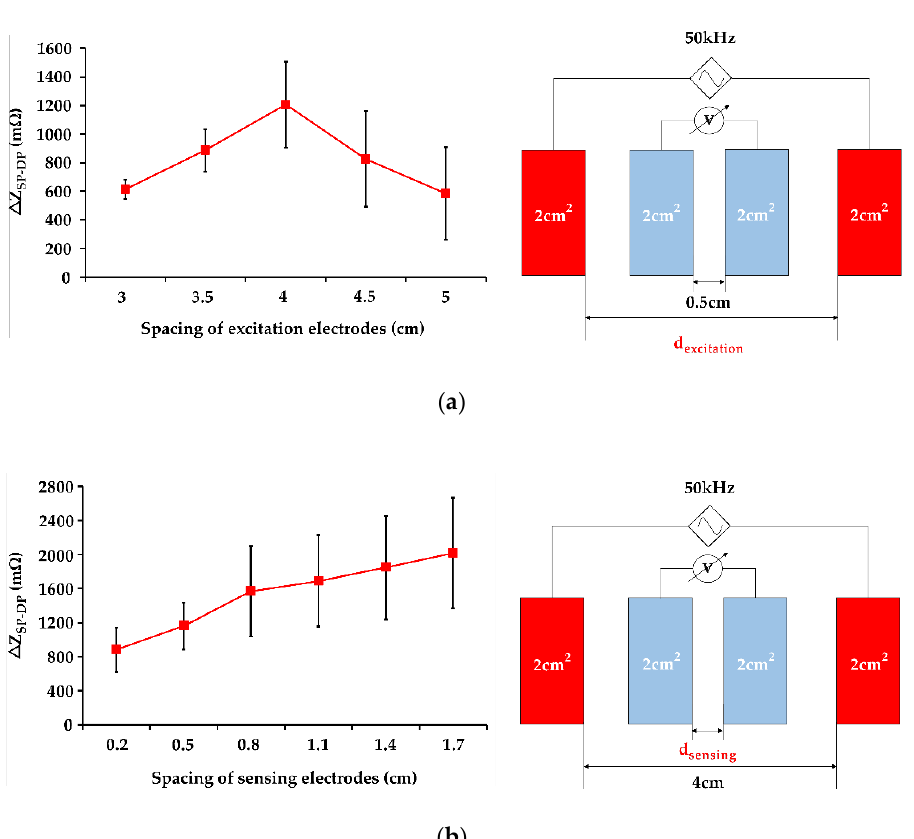
Figure 8. The influence of different ( a ) excitation spacing (from 3 cm to 5 cm) and ( b ) sensing spacing (from 0.2 cm to 1.7 cm) on IPG resolution measurement (n = 6). 3.4. Influence of Left and Right Side Carotid Artery on IPG Measurement Resolution To investigate the influence of the carotid arteries in the left and right sides of the neck on IPG measurement, simultaneous IPG recording was performed in this study. Two same IPG systems were installed above the carotid arteries in right and left neck with consistent excitation frequency, electrode area, and electrode spacing. The comparison re- sults show that the arterial impedance changes on the left side of the neck obtained a higher impedance difference of 2137 mΩ than the right side of 1949 mΩ , as shown in Fig- ure 9.